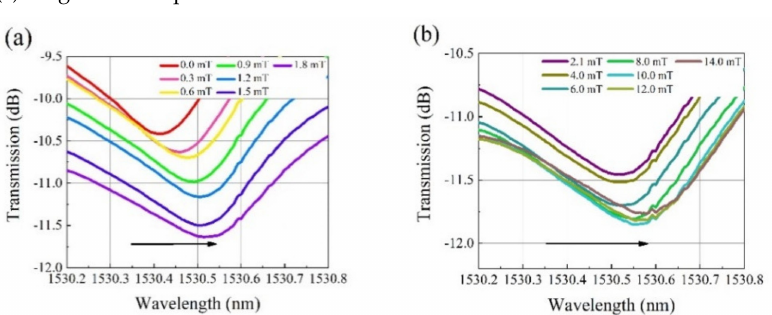
Figure 4. ( a ) Schematic of magnetic nanoparticles within magnetic fluid under zero magnetic field. ( b ) Schematic of magnetic nanoparticle columns within magnetic fluid under applied magnetic field. ( c ) Magnetic nanoparticle column distribution in PCF.